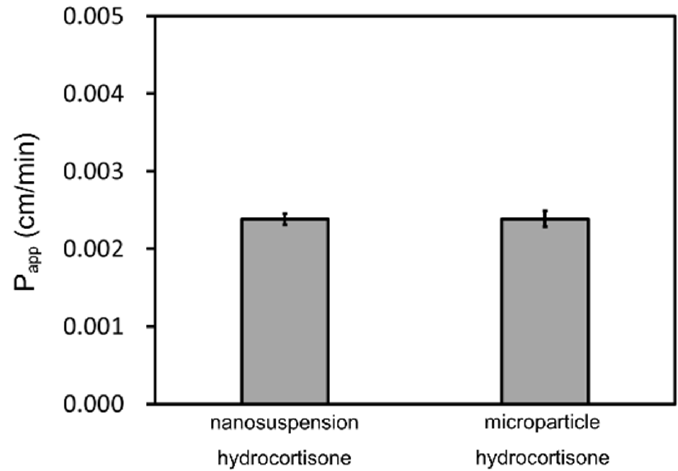
Figure 7. Hydrocortisone concentration–time profile in: ( a ) the acceptor chamber; ( b ) the donor chamber. The results represent the average hydrocortisone concentration ± SD ( n = 3) for nanosuspension hydrocortisone ( ◇ ) and microparticle hydrocortisone ( △ ).